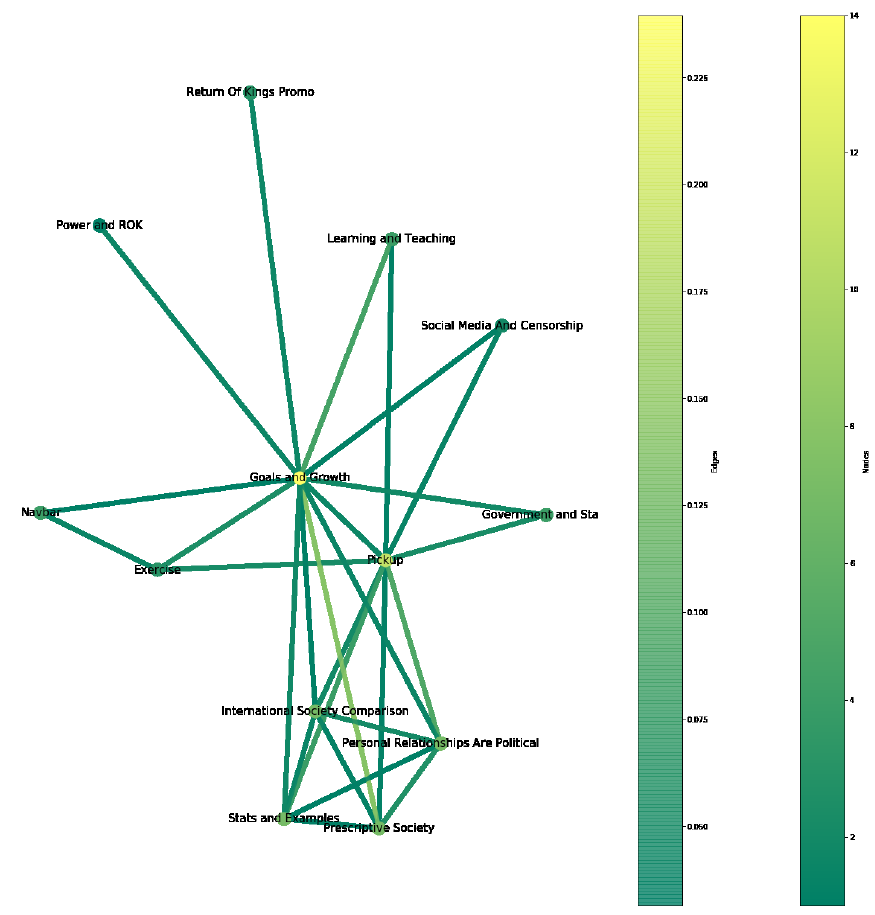
Figure 1. Network graph of topic co-occurrence. Edges are coloured by co-occurrence strength. Nodes are coloured by the number of links remaining after the removal of all edges under a strength of 0.03.